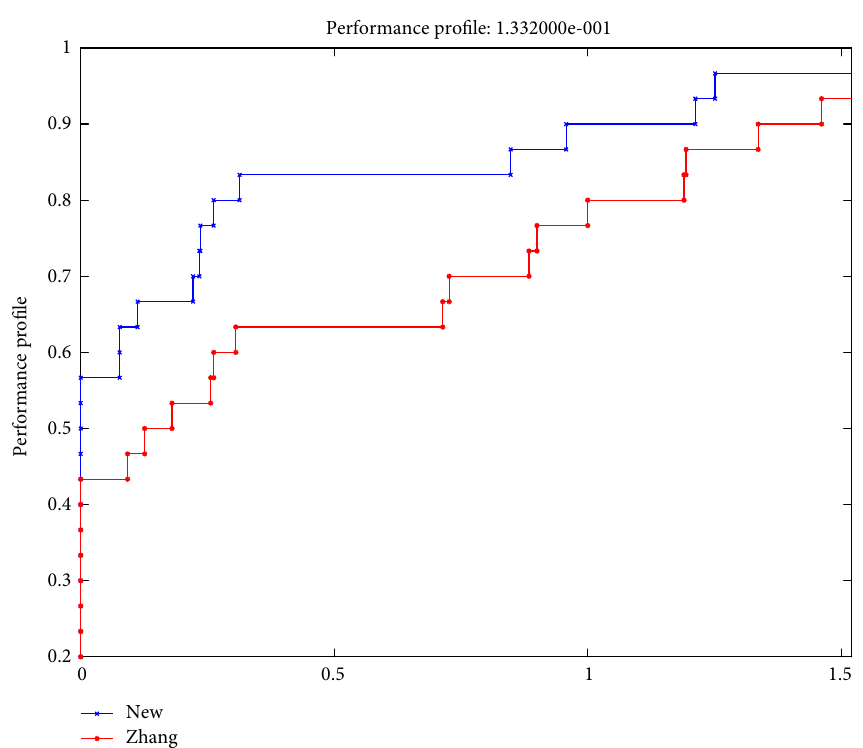
Figure 3: Performance profiles based on number of